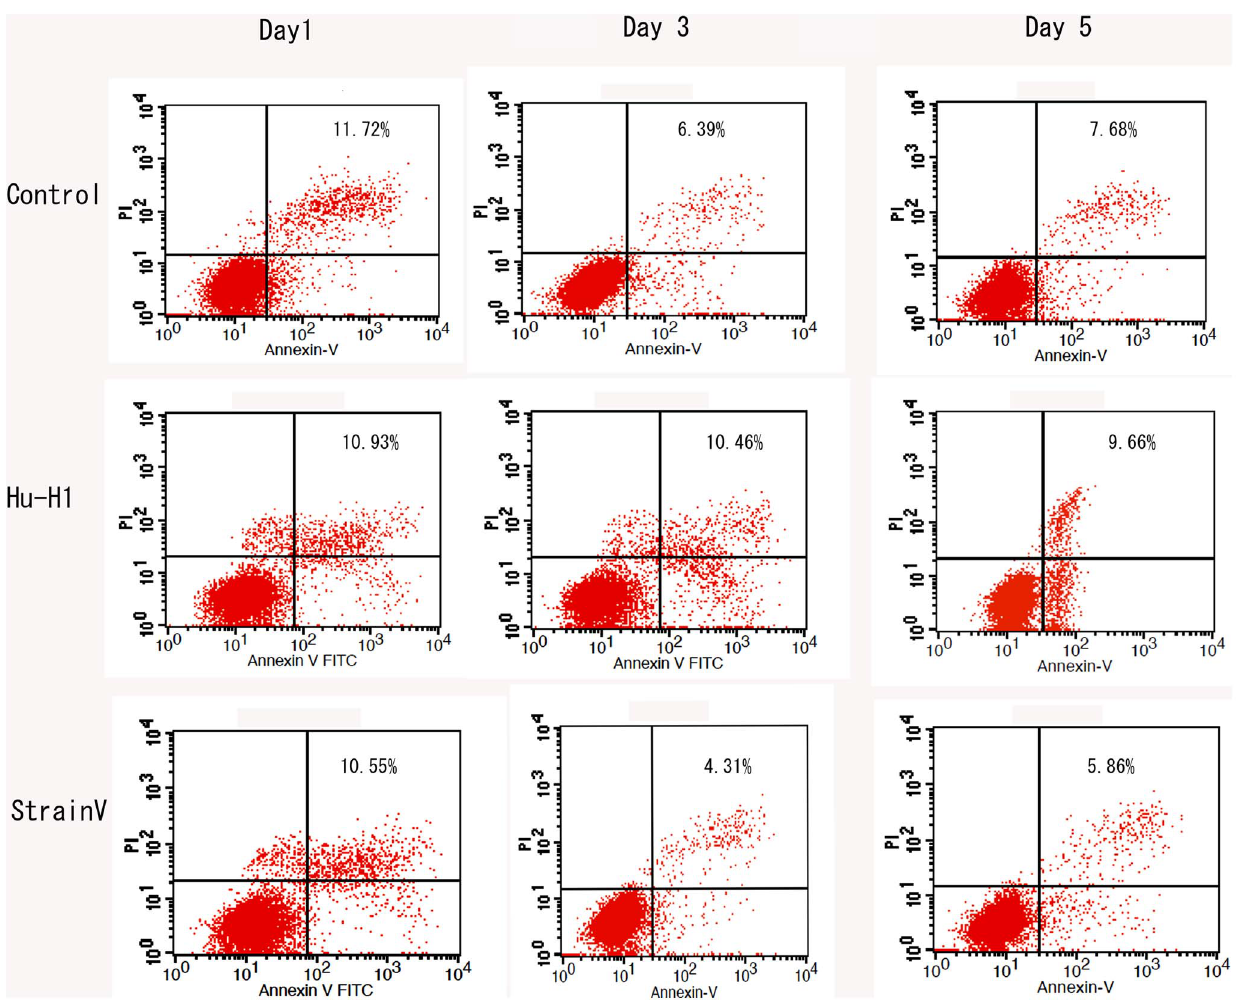
Figure 5. Apoptotic cell counts of Hu-H1, Strain V, and control cells.